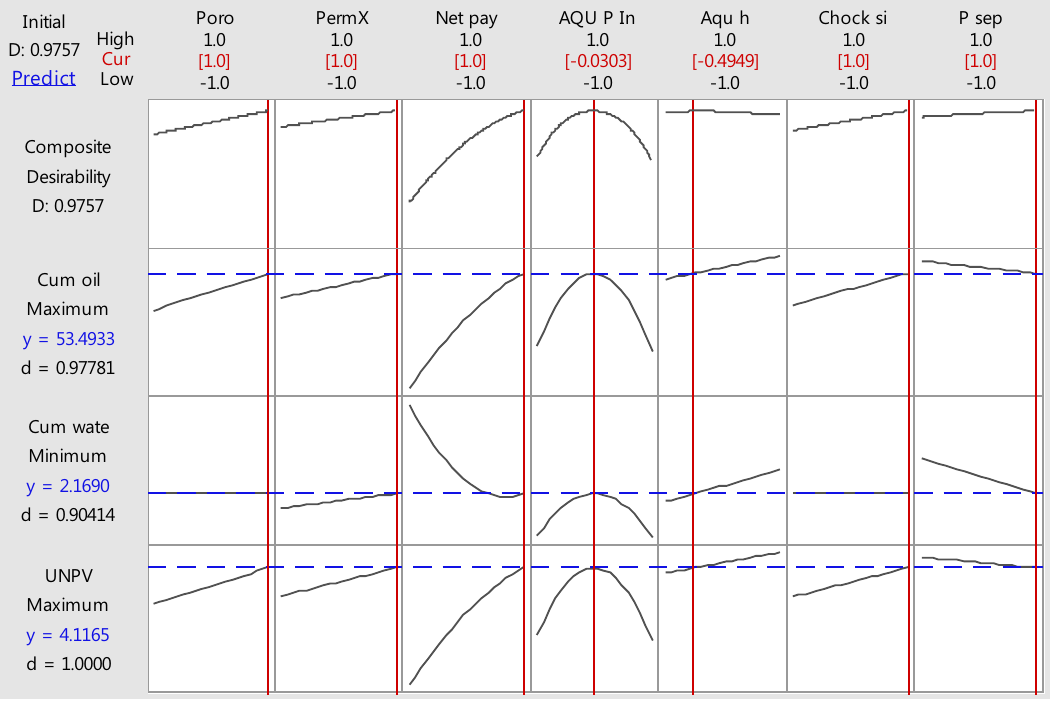
Fig. 6 The impact of each effective seven parameters on target functions and composite